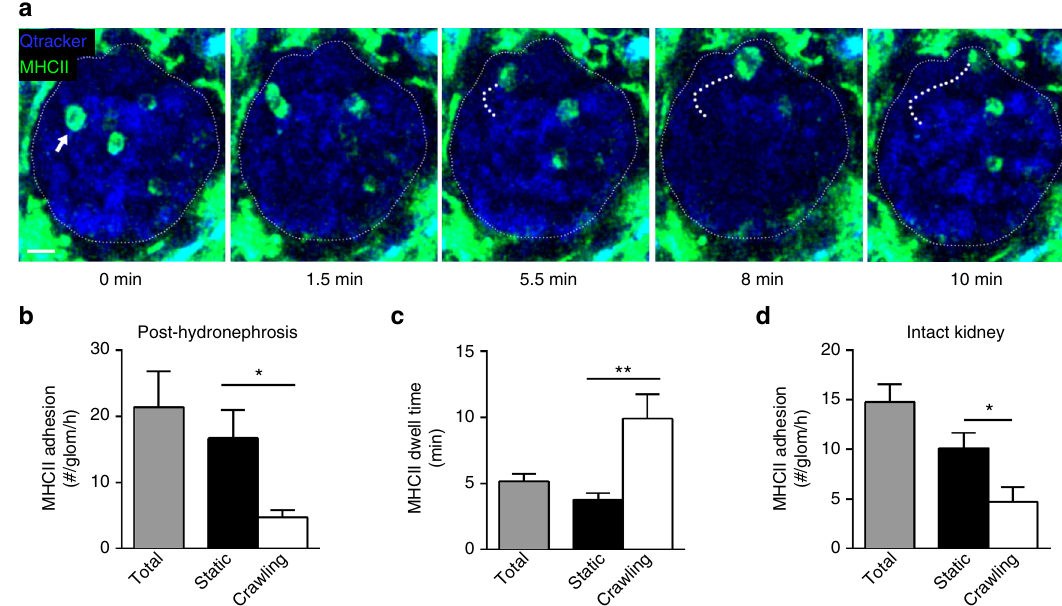
Fig. 3 MHCII + immune cells constitutively migrate in glomerular capillaries. Multiphoton microscopy was performed on glomeruli of unin fl amed MHCII- EGFP mice. a Image sequence showing actions of adherent EGFP + leukocytes (green) in glomerular capillaries (vasculature detected via Qtracker ® 655, blue). Arrow (left panel) indicates a crawling EGFP + leukocyte. See also Supplementary Movie 5. The migration path of the cell is indicated by the thick dotted line in subsequent images (time elapsed shown below). Glomerular border is denoted by a thin dotted line. Scale bar represents 10 μ m. b – d Quanti fi cation of adhesion and migration of MHCII + cells undergoing retention in glomeruli of untreated post-hydronephrotic mice ( n = 6 mice). Data are shown for MHCII + leukocyte adhesion ( b ) and dwell time ( c ) (shown for total, static, crawling in both). Data in c are expressed per cell: total n = 400, static n = 310, crawling n = 90 cells. d Number of adherent MHCII-EGFP + leukocytes (total, static, crawling) in glomeruli of intact kidneys of 3 – 4-week-old mice ( n = 7 mice). See also Supplementary Movie 6. Data are presented as mean ± s.e.m. * P < 0.05; ** P < 0.01. b , c Mann − Whitney tests; d